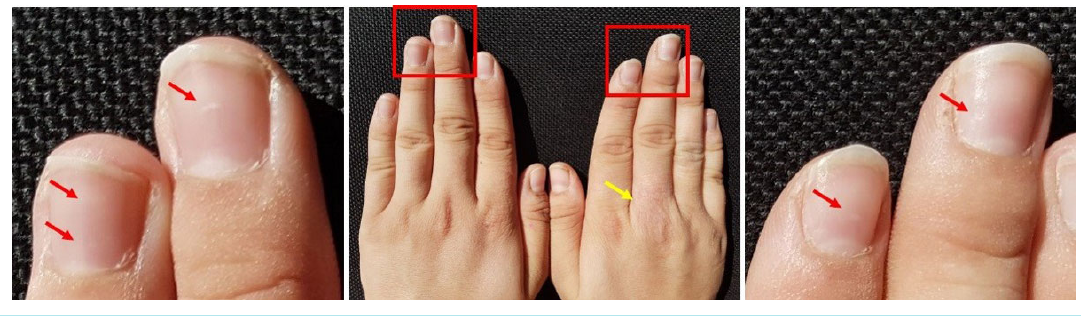
Table 1: Patient’s characteristics before treatment as of 17 May 2018 (age 16.5 years), and after treatment as of 12 October 2018 (age 16.9 years). Age BH BW BMI eSW eSP iAs, blood iAs, morning (years) (m) (kg) (kg/m 2 ) (g) (g) (μmol/l) urine (nmol/l)